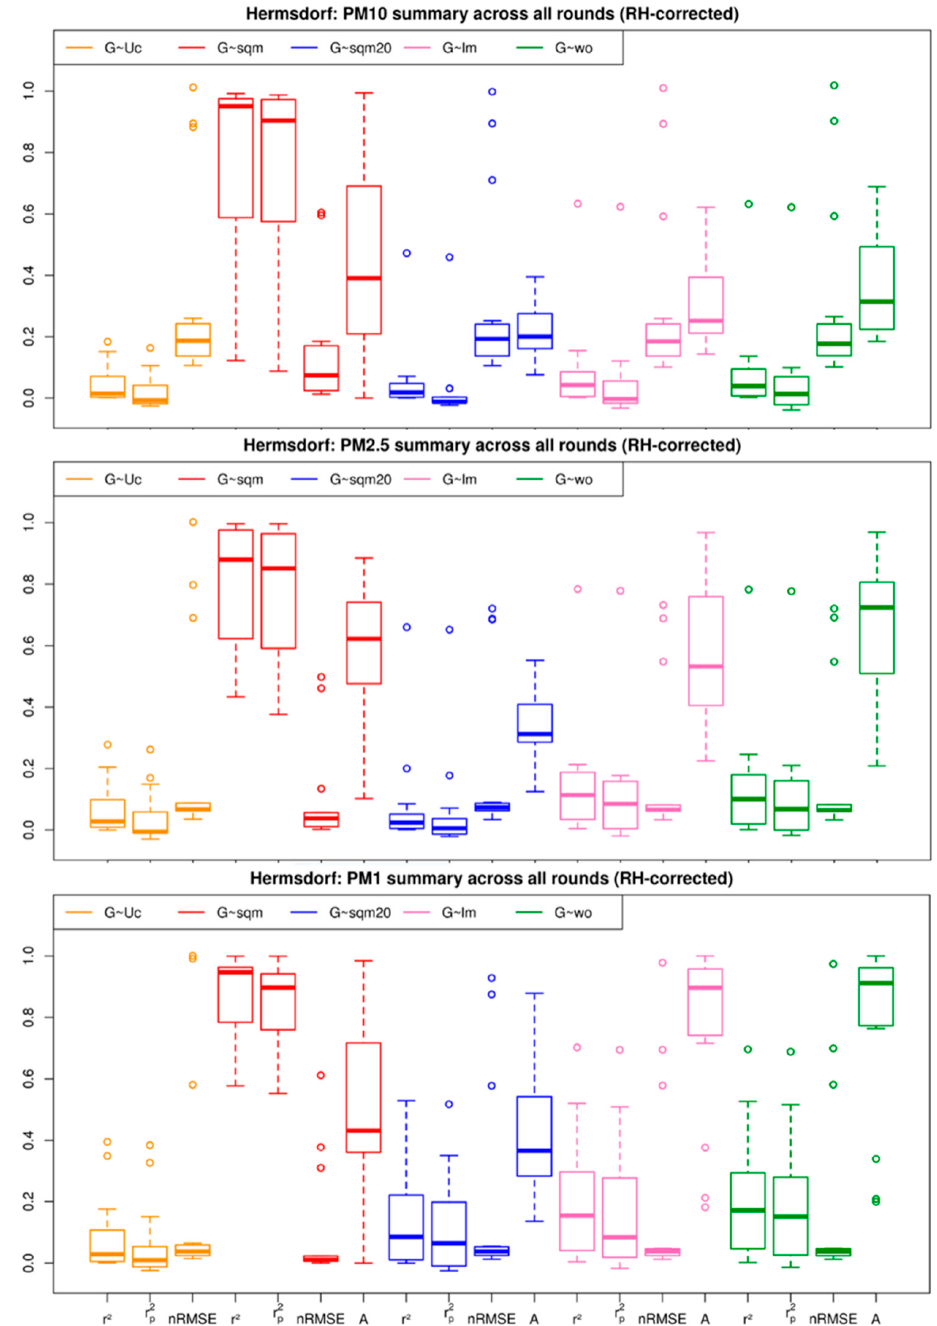
Figure 8. Summary of different correction methods, namely coefficients of determination ( r 2 ), the predicted coefficient of determination ( r 2 p ), and the normalized mean square of deviation (nRMSE) for RH corrected PM10, PM2.5 and PM1, for the measurement campaign in Berlin-Hermsdorf. The Accuracy (A) is also provided for the correlations between the Grimm 1.109 and URMBOBI 3.0 raw data (G~Uc), Grimm 1.109 and URBMOBI 3.0 corrected data using quantile method with 100% data (G~sqm), Grimm 1.109 vs. URBMOBI 3.0 corrected using quantile method with 20% data (G~sqm20), Grimm vs. URBMOBI 3.0 corrected with linear regression (G~lm), and Grimm 1.109 and URBMOBI 3.0 with all outliers removed (G~wo).